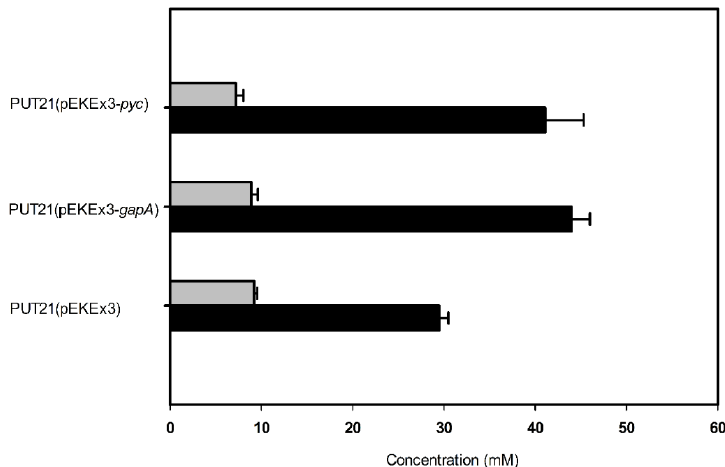
Figure 4. Effect of pEKEx3-based overexpression of gapA and pyc in PUT21 on the production of putrescine (black bar) and N-acetylputrescine byproduct (grey bar). Cells were grown in CGXII medium with 20 g·L −1 glucose and 1 mM isopropyl β- D -1- thiogalactopyranoside (IPTG). Means and standard error of three independent cultivations are